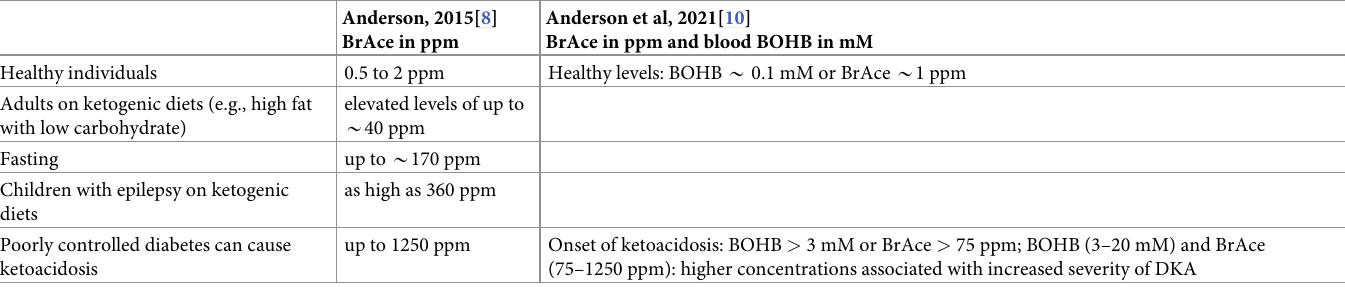
Table 1. Breath acetone concentrations as reported in Anderson, 2015 [8] and Anderson et al, 2021